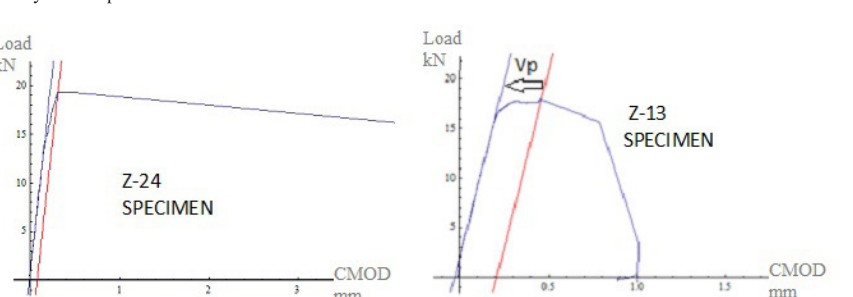
Figure 4. Geometry of the specimen.